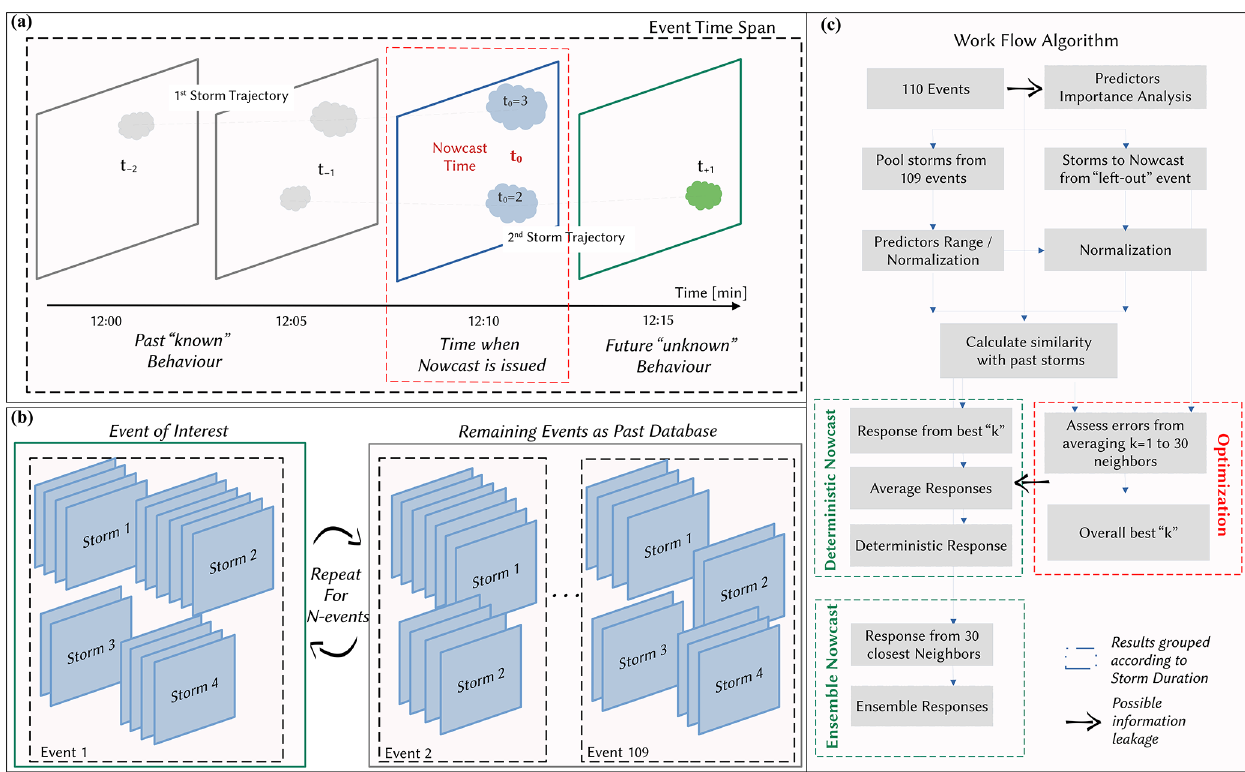
Figure 3. Illustration of concepts and workflows in this study. (a) An event contains many rainfall storms inside the radar range which are tracked and nowcasted: the dashed grey lines indicate the movements of storms in space and time within the radar event and the event time span. (b) The “leave-one-out-event cross-validation” – the storms of the event of interest are removed from the past database, and the nowcast of these storms is issued based on the past database. This process is repeated 110 times (once for each event). (c) The workflow implemented here for the optimization and application of the k -NN approach.